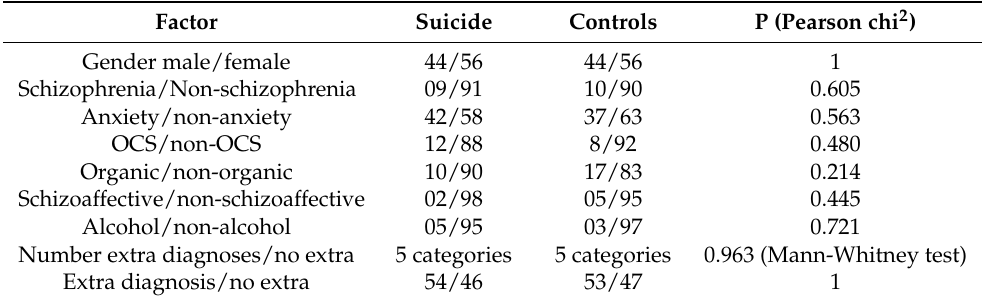
Table 2. Bivariate calculations and statistics for factors related to